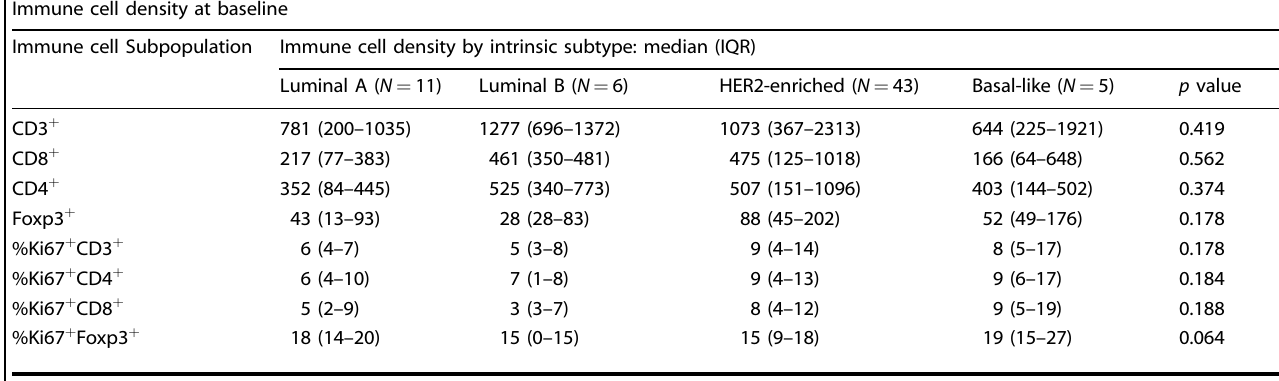
Table 1. Immune cell density at baseline and after 2 weeks of anti-HER2 treatment according to baseline PAM50 intrinsic subtype. Immune cell density at